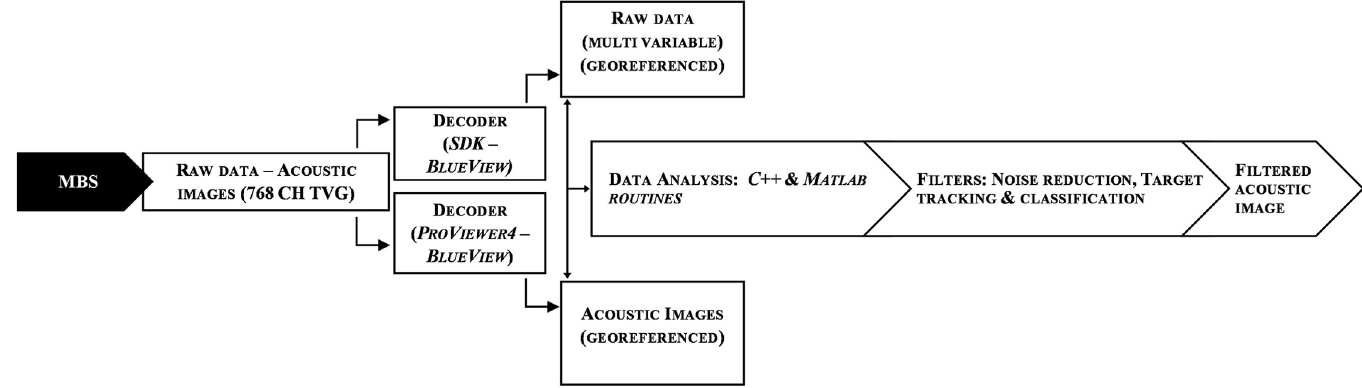
Fig 5. Architecture of the data acquisition and processing for detecting, tracking and classifying underwater targets of interest. The MBS signal is promptly processed by the SDK/ProViwer software running on C++ programming environment. The acoustic images are then analysed and filtered using the SDK/ProViewer and Matlab—Image processing Toolbox